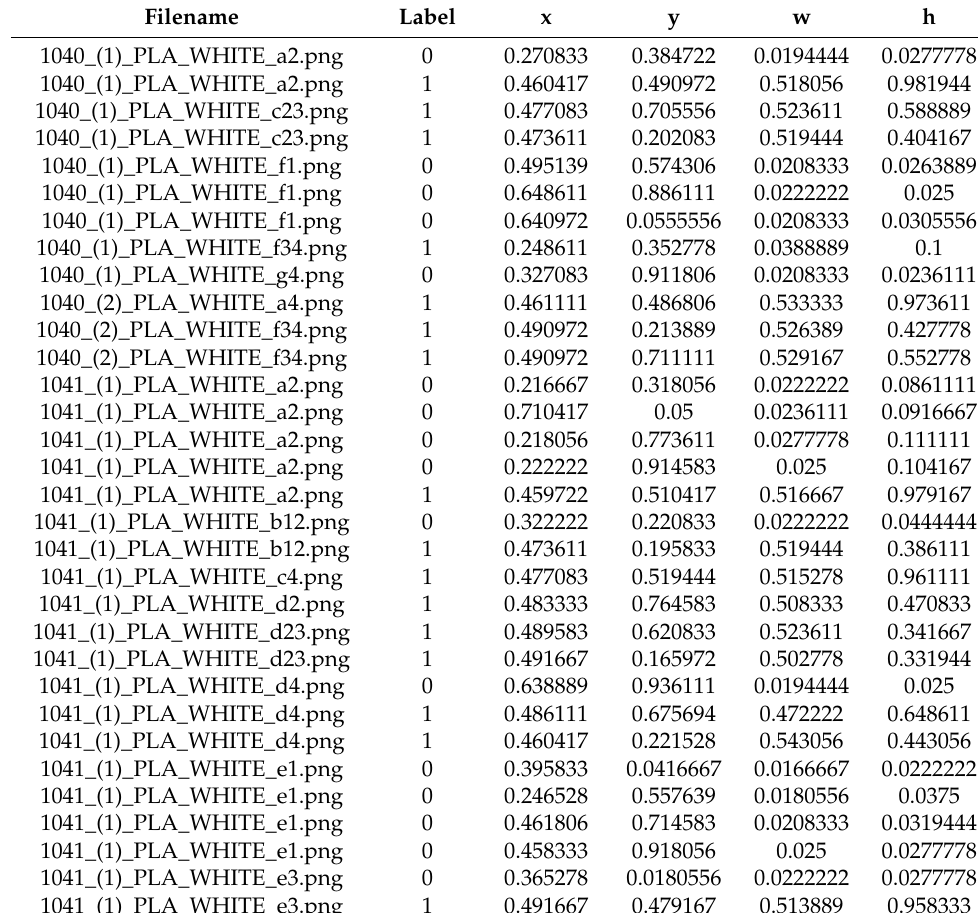
Table 6. Result table that outlines defects and their relative position on the x-y